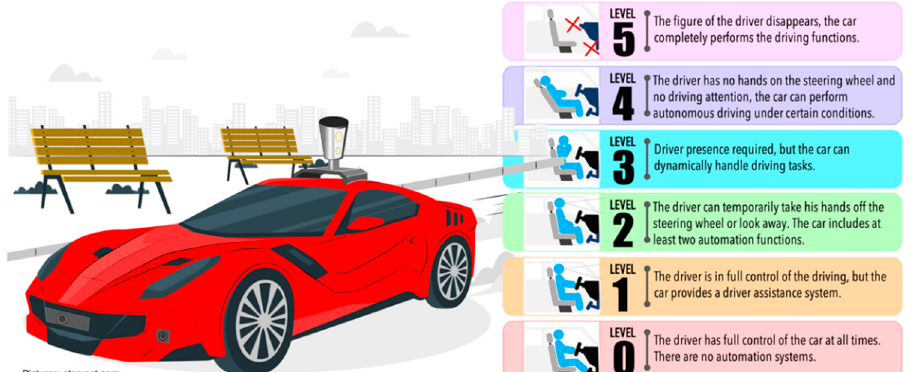
Figure 2. Brief description of the six levels of vehicle driving automation defined by the Society of Automotive Engineers. The figure is based on the content presented in [7].